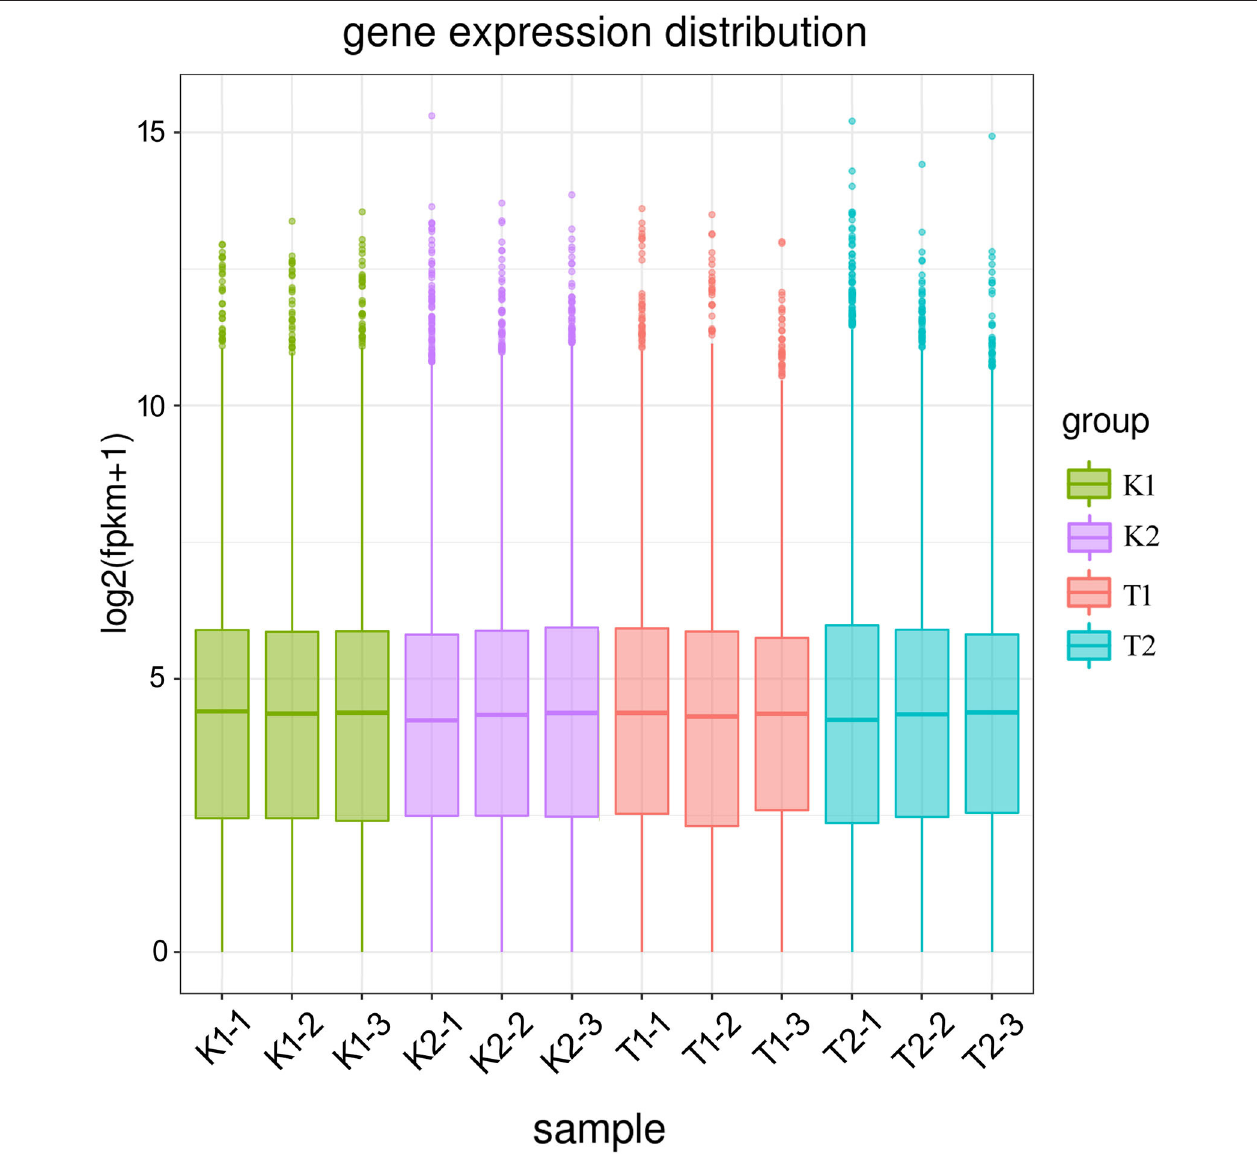
FIGURE 1 | Box plot of gene expression across samples. A total of 12 samples were assigned to four groups; K1 (K1-1, K1-2, K1-3) was the control group of strain BH01; K2 (K2-1, K2-2, K2-3) was the control group of strain BH03; T1 (T1-1, T1-2, T1-3) was the treatment group of strain BH01; Group T2 (T2-1, T2-2, T2-3) was the treatment group of strain BH03. FPKM: expected number of fragments per kilobase of transcript sequence per millions base pairs